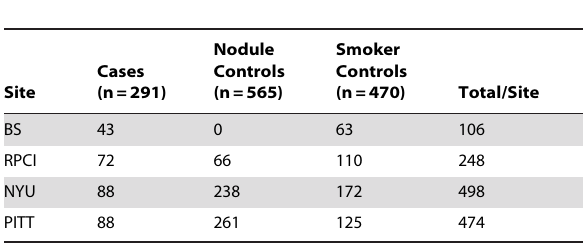
Table 1. Sample cohort by independent study